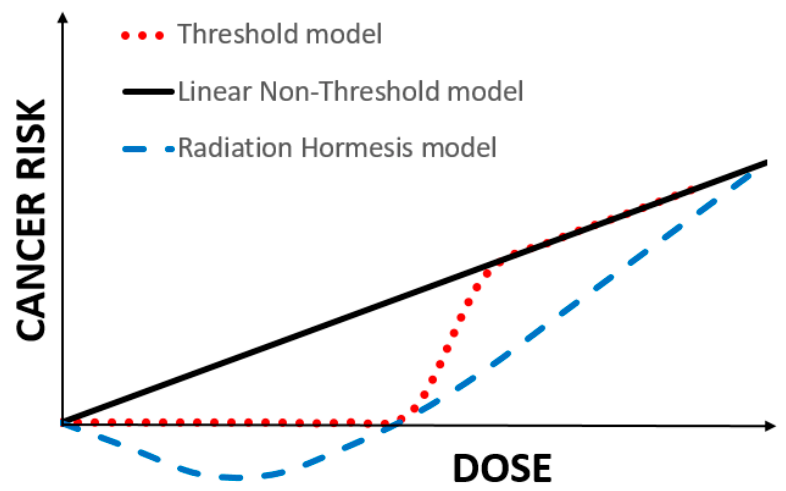
Figure 1. Schematic representation of the three main dose–response models linking cancer risk to dose of IR exposure. The Linear Non-Threshold (LNT) model states that cancer risk increases with dose in a linear fashion from a dose of zero units onwards. It is supported by human epidemiological data at intermediate to high doses, whereas supporting evidence in the low dose region ( < 100 mGy) is weak. The LNT is a foundation of the regulatory policies put forth by the International Commission on Radiological Protection. The Threshold model implies the existence of a threshold dose, below which no measurable increase in cancer risk is observed. The radiation hormesis model assumes a negative cancer risk at low-dose exposures, resulting in protection from cancer. The radiation hormesis model is supported by a large body of radiobiological literature showing beneficial responses to LDR, including in vivo animal cancer and mortality studies.